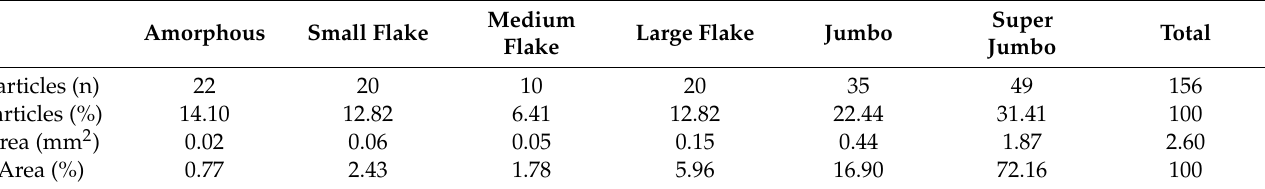
Table 8. Physical properties of graphite as determined by CT in the topmost slice after segmentation.